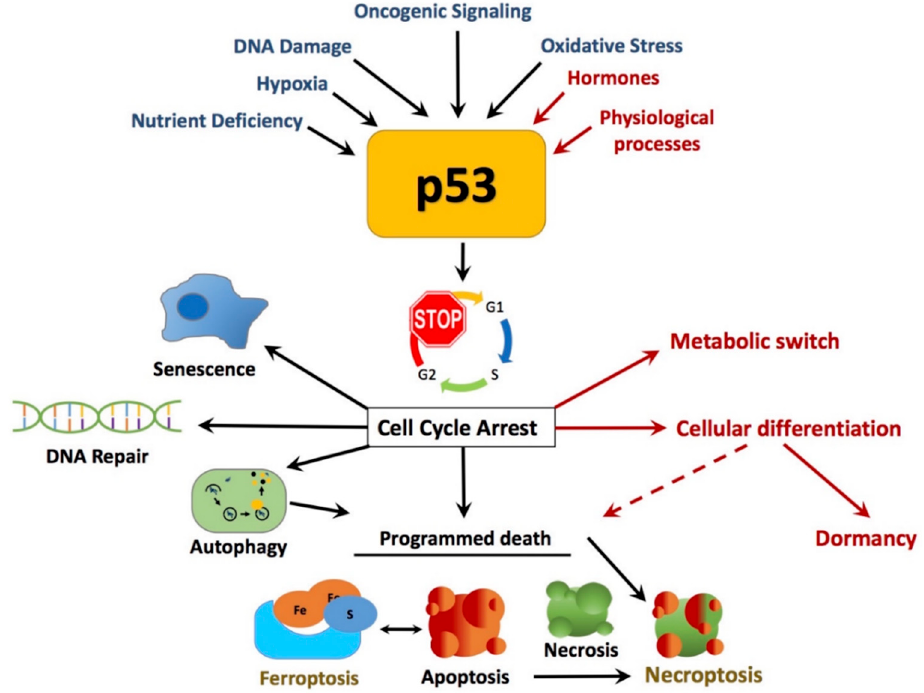
Figure 1. p53 canonical and non-canonical tumor suppressor roles of p53. p53 is activated by a range of cellular stress signals. These activators of p53 include nutrient stress, hypoxic conditions, activation of oncogenes, DNA damage, and oxidative stress from reactive oxygen species (ROS) and, as a result, increase the activity of p53. Classical or canonical responses of p53 include, transcriptionally and translationally, cell cycle arrest and repair damage to DNA, which place the cell in a state of senescence or induce apoptosis. Non-canonical, controlled programmed cell death roles include autophagy pathways, necrosis, necroptosis, and ferroptosis [5,48,50–53,62–64]. Normal physiological processes such as hormone activation can also lead to p53-induced cell cycle arrest and p53 acts as a switch in metabolic process involved in differentiation, redirecting specialized cell function [9].